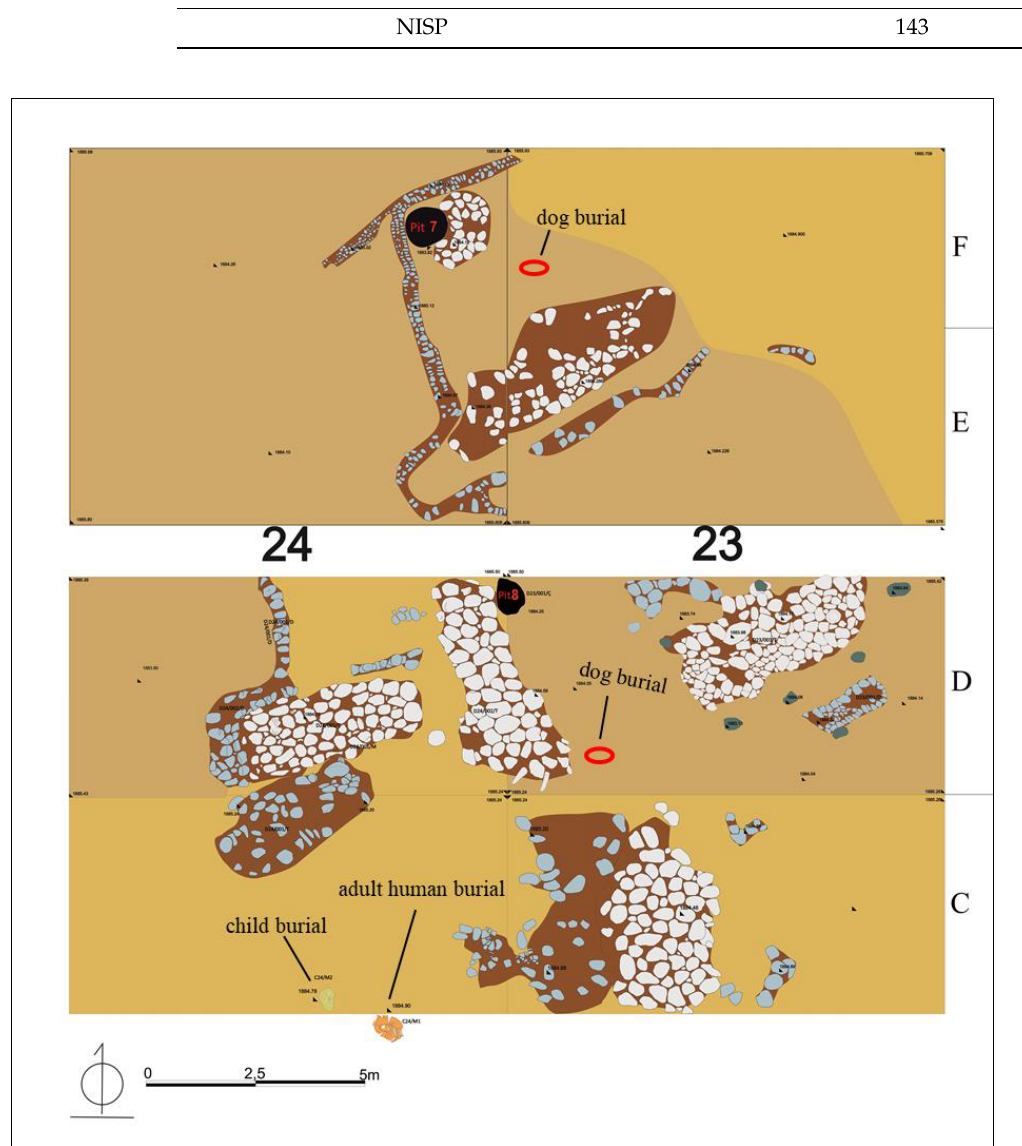
Figure 4. Location of the dog burials from the Iron Age workshop complex: each of Trench D 23 and F 23 respectively revealed single in situ dog skeleton (photo from Alaybeyi Höyük Archive).